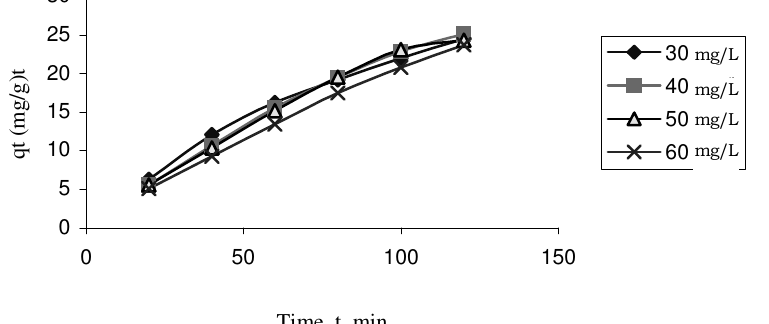
Figure 7. Elovich plot - effect of contact time on Grey BL by MLP